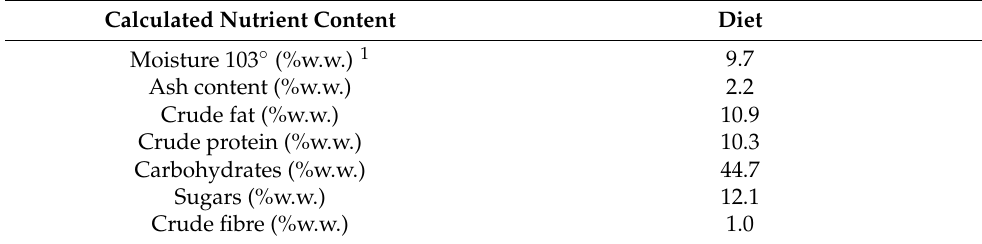
Table 1. Biscuit flour nutrient